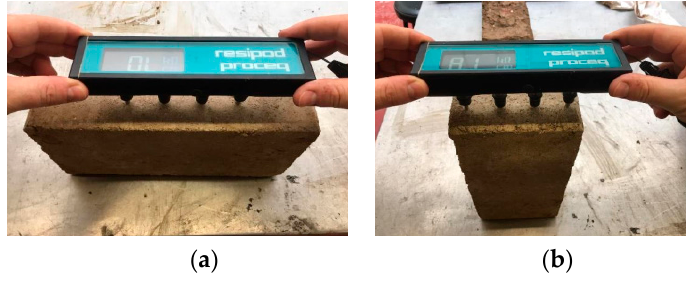
Figure 2. Electric resistivity test: measurements were done in two samples faces—( a ) width and ( b ) length.